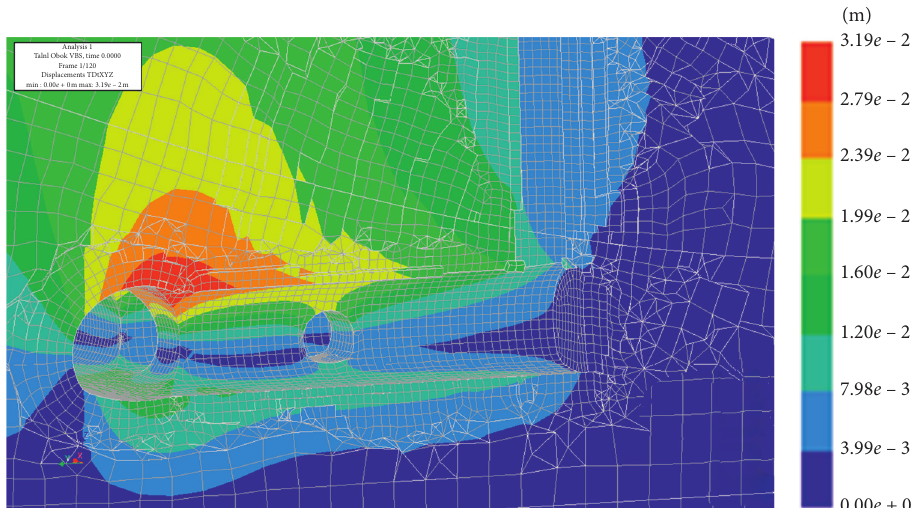
Figure 16: Ground displacements after tunnel